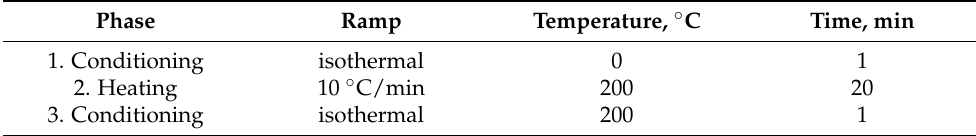
Table 3. Conditions for DSC